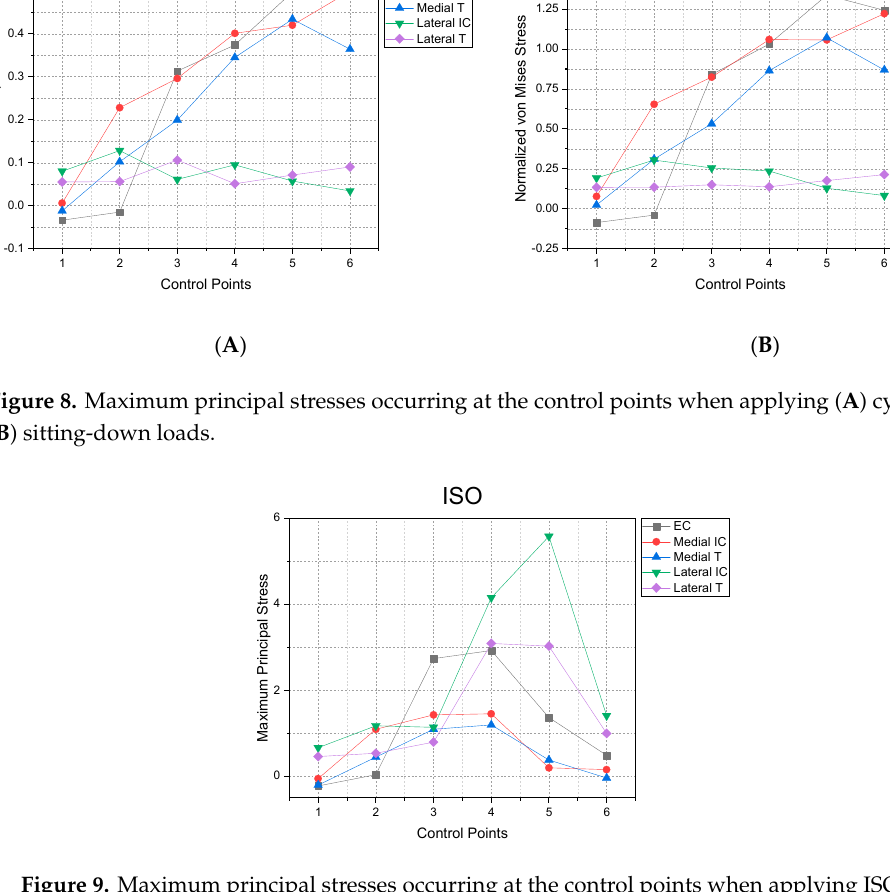
Figure 9. Maximum principal stresses occurring at the control points when applying ISO load.